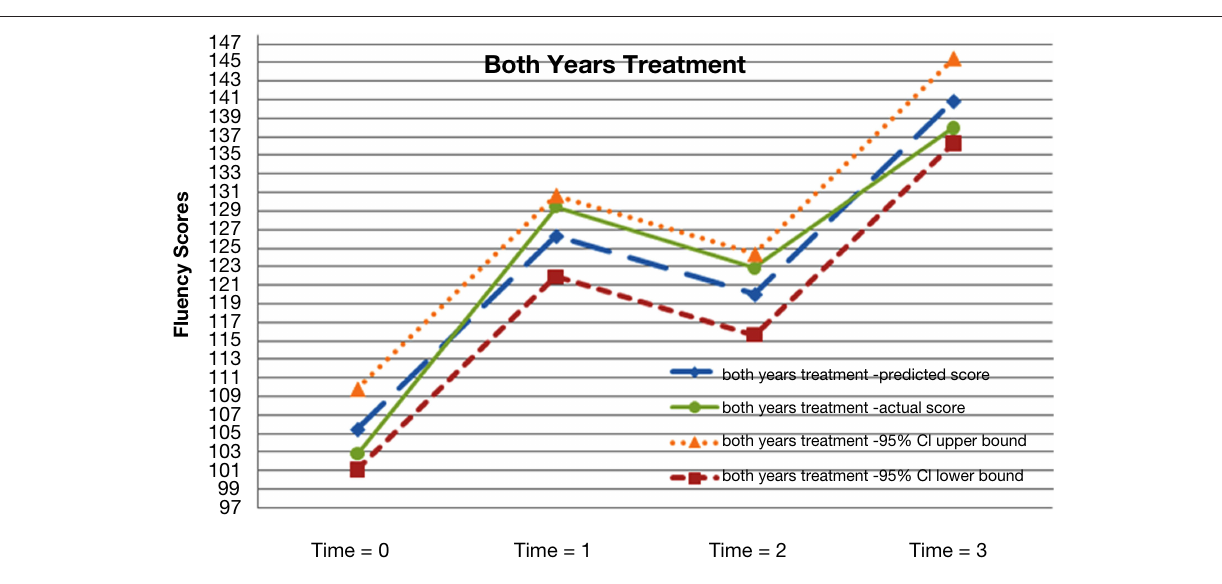
Figure 5 | Actual and predicted growth trajectories for students who received the treatment during both years as well as 95% confidence intervals around the predicted growth